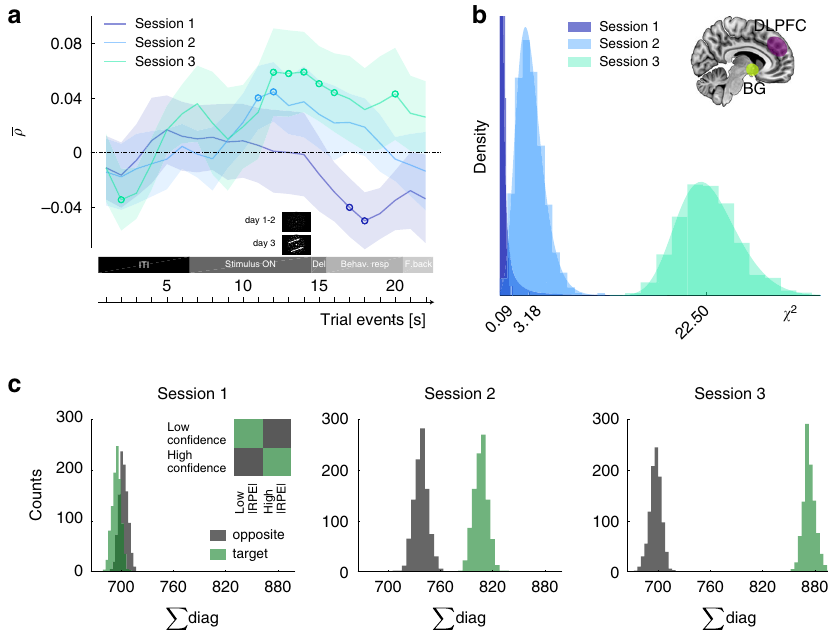
Fig. 6 Correlations between con fi dence, latent state and reward-prediction error. a Con fi dence judgements correlated with the amount of latent RL state evidence. Spearman rank correlation was computed for each subject between the trial-by-trial con fi dence ratings and the trial-by-trial dot product of decoder weights with voxels activities. Correlation coef fi cients were Fisher-transformed. Y -axis: ρ , coloured lines represent the group mean, shaded areas the SEM, circles the locations in time where the correlation was signi fi cantly different from zero ( t -test against 0-mean, two-sided p values, FDR corrected). b Multivoxel pattern association between basal ganglia and prefrontal cortex supporting con fi dence – |RPE| correlation. A decoder for con fi dence was built from multivoxel patterns in the DLPFC, while a decoder for |RPE| was built from multivoxel patterns in the basal ganglia. For each session, the original data were randomly resampled N = 1000 times at the subject level and then pooled across the population to create a χ 2 distribution to indicate the degree of association between con fi dence and |RPE|. The distributions are plotted as histograms, overlaid with a shaded area generated from a standard generalized extreme value fi t. c The histograms are based on the same distributions as in b , displaying here the sum of the occurrences of predicted con fi dence paired with predicted |RPE|. Target (green colour) is the sum of the occurrences where predicted high con fi dence paired with predicted low |RPE| (and vice versa). Opposite (dark grey colour) denotes the reverse pairing pattern (e.g., predicted high con fi dence − predicted high |RPE|). In b , c , N = 1000 resampling runs per subject, then pooled across the population. The experiment was conducted once ( n = 18 biologically independent